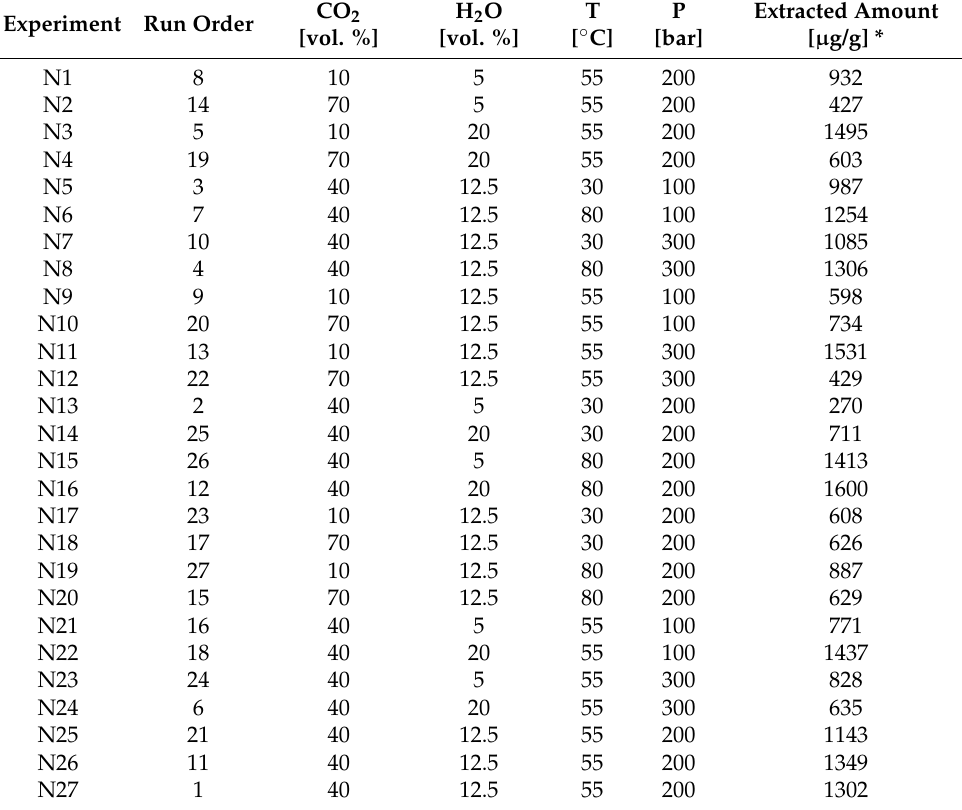
Table 1. Set of experiments for SFE/GXLE optimization using Box-Behnken